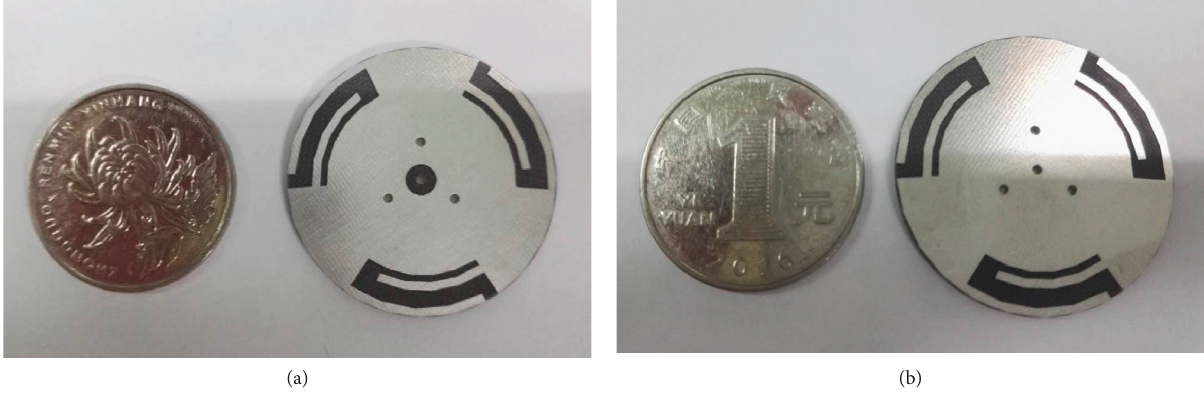
Figure 10: The proposed CP antenna bottom (a) and top